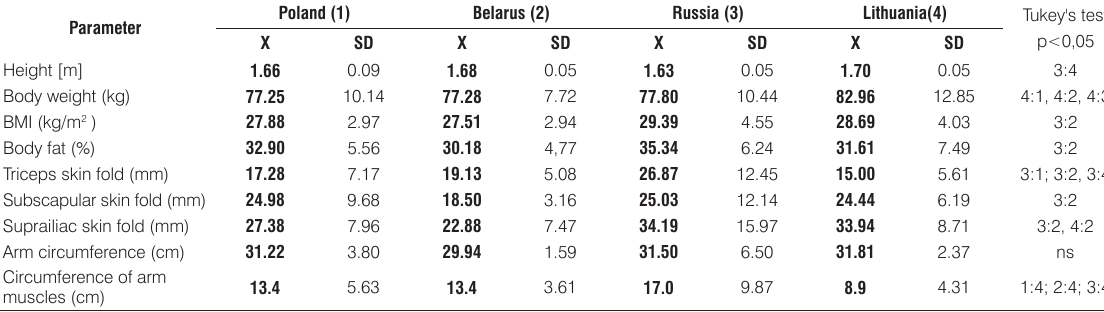
Table 2. Anthropometric characteristics of female students with BMI > 25 kg/m 2 .